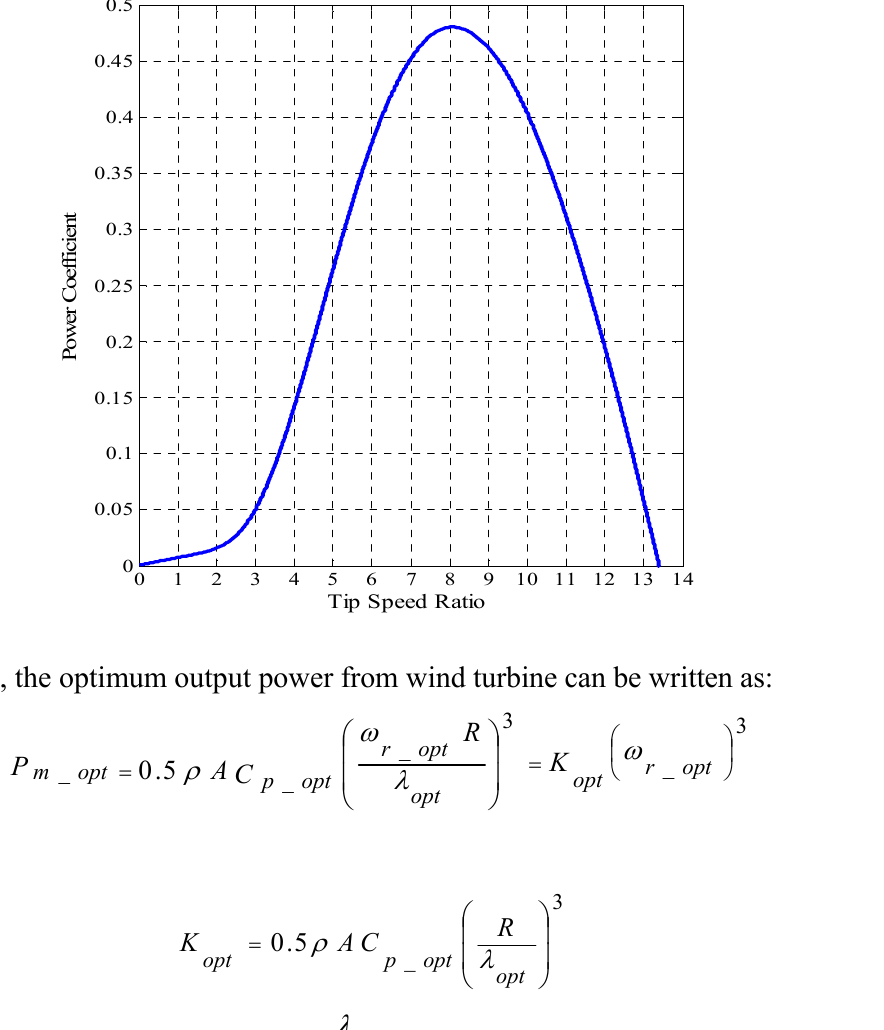
) and tip speed ratio ( λ p